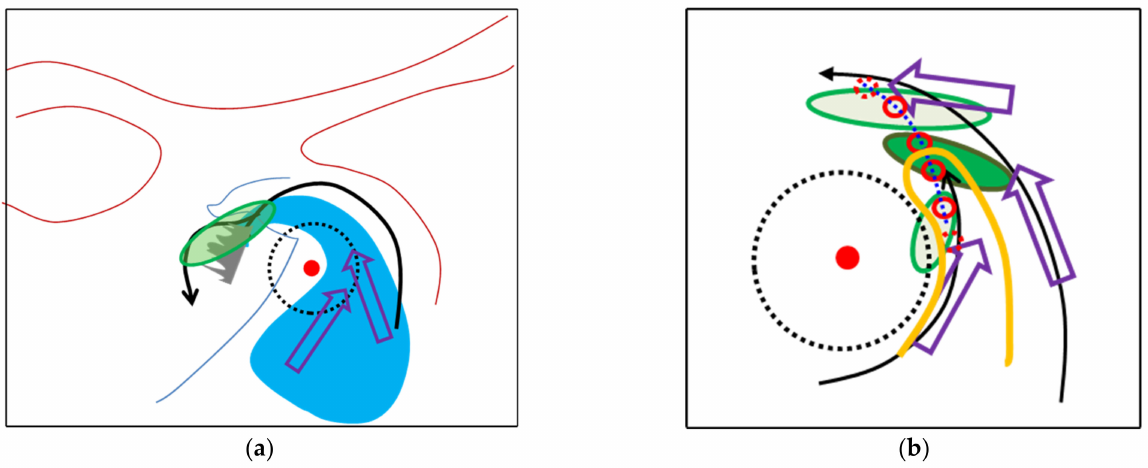
Figure 15. Conceptual schematic diagram of the main precipitation impaction factors during the periods of ( a ) affecting Zhejiang (before landfall) and ( b ) affecting Jiangsu (via slow northward movement). Brown contour: 500-hPa geopotential height; purple arrows: low-level jets; black arrow: streamline in lower troposphere; green-shaded area: convergence areas; blue-shaded area: water vapor transport; orange line: high-humidity and high-energy tongue; blue dashed line: mesoscale rainband; red circle: